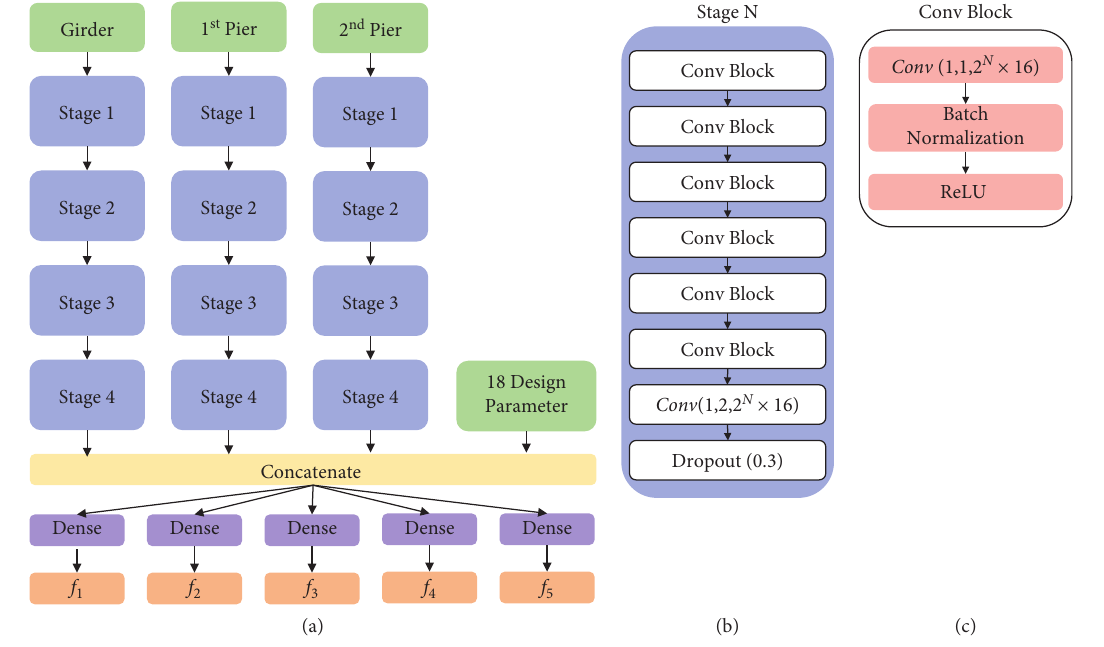
Figure 6: The 3D-CNN architecture. (a) 3D-CNN architecture. (b) Details of stage. (c) Details of conv